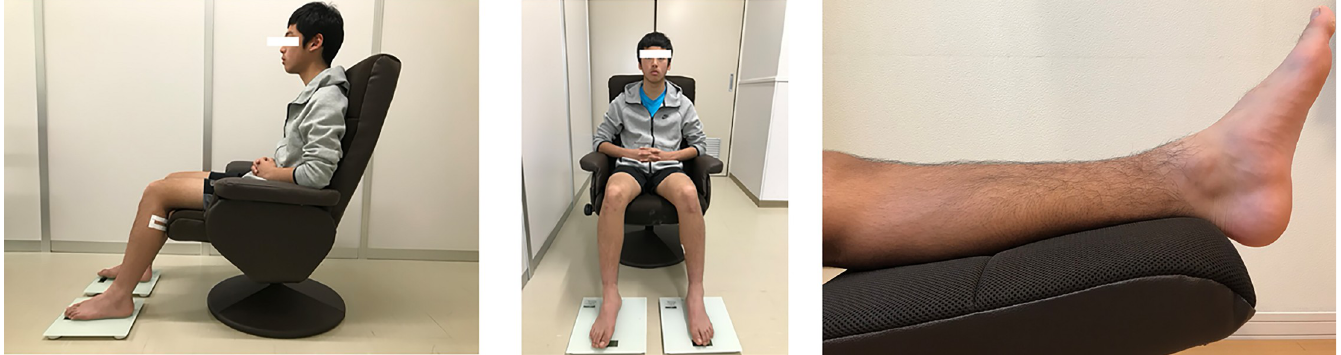
Fig 2. a. Sitting position on a reclining chair. b. Leg raise on a stool.